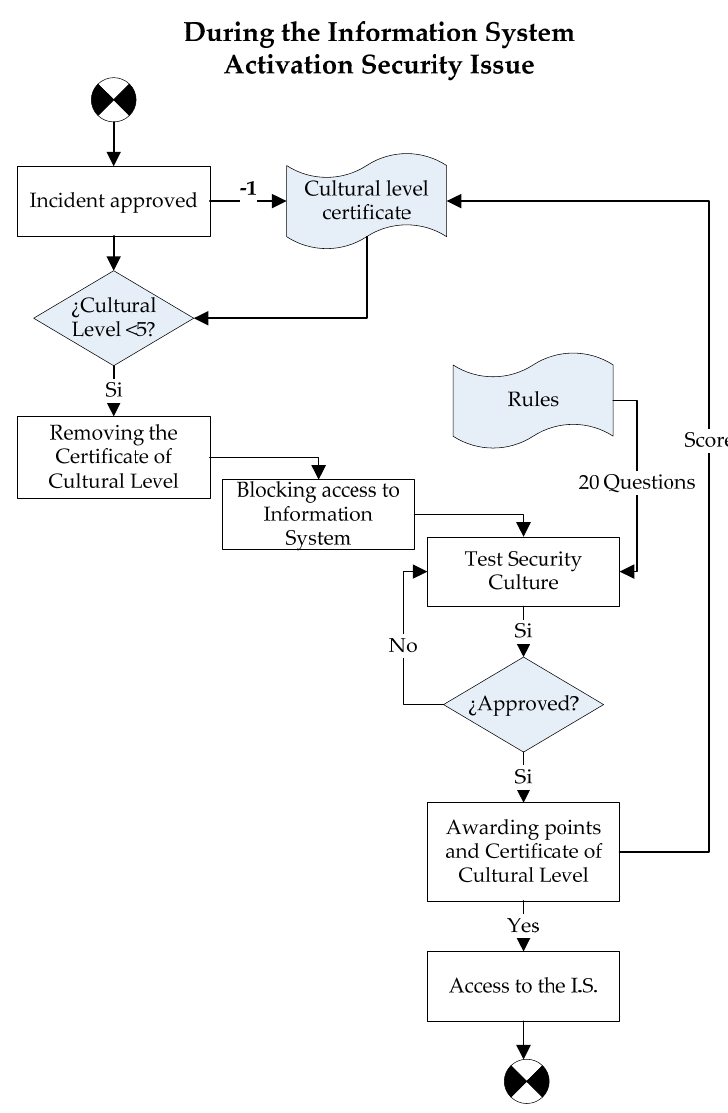
Figure 8. Alteration of Level Security Culture (LSC) owing to a violation of the regulations.